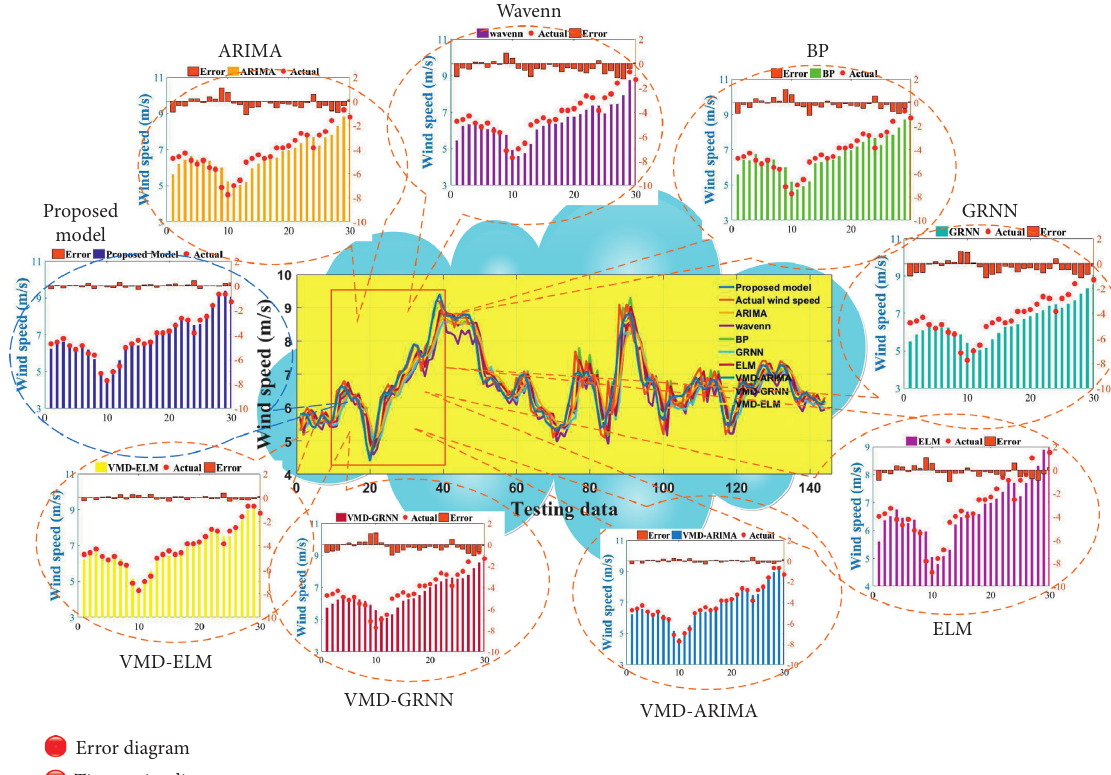
Figure 3: The multistep prediction performance of all models in experiment I for dataset1. The center of the picture is a one-step prediction time series figure. Around it are the error diagrams of eight comparison models and the proposed